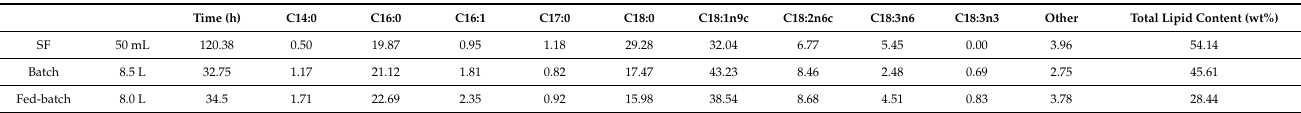
C18:1n9c) (Table 1) fatty acids and polyunsaturated fatty acids are represented only by gamma-linolenic acid (GLA, C18:3n6), whereas in M. alpina SCO the presence of GLA and arachidonic acid (ARA, C20:4n6) was found and dominated over the saturated and mo- nounsaturated fatty acids (Table 2). These results are in agreement with the ones reported previously by Kosa et al., 2018 [32] and Dzurendova et al., 2020 [21] for fermentations in glucose media. Table 1. Fatty acid composition (% wt of total lipid weight) for M. circinelloides single cell oil obtained from cultivation on animal fat rest materials.